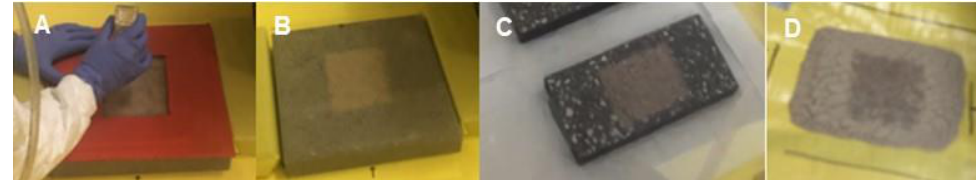
Figure 1. Application of simulated fallout material (SFM) to tested surfaces. ( A ) Use of stencil to define target area; ( B ) Concrete; ( C ) Asphalt; ( D ) Sand.